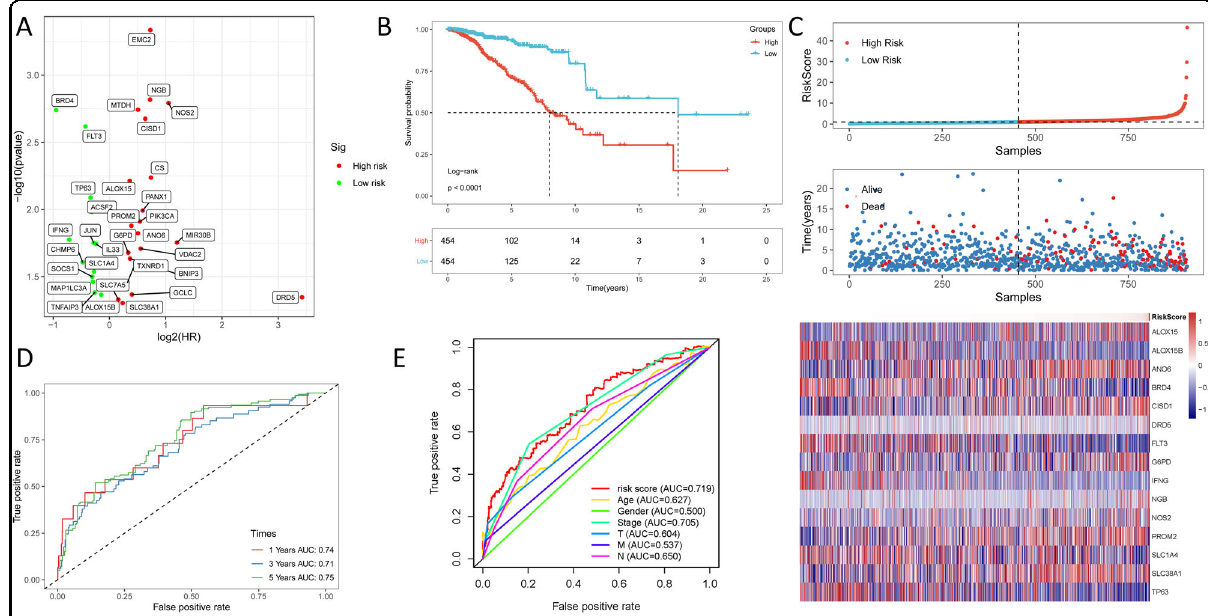
Fig. 2 Evaluate the accuracy of the ferroptosis-related gene signature based on TCGA. A Univariate COX analysis identi fi ed 33 ferroptosis- related genes; red means upregulated and greed means downregulated genes; B Kaplan – Meier indicated that high-risk group (red) exhibited a poorer survival outcome when compared to the low-risk group (blue); C The top graph represents the classi fi cation of patients into high (red) and low (blue) risk groups based on risk scores, the middle graph represents as the patient ’ s risk score increased, the mortality rate also increased, the bottom heatmap represents the change of 15 ferroptosis-related genes as the risk score increases; D The AUC values of the patients ’ 1, 3, 5-year survival rate; E the AUC of the signature was 0.719, exhibiting superior performance than the traditional clinicopathological features in predicting the